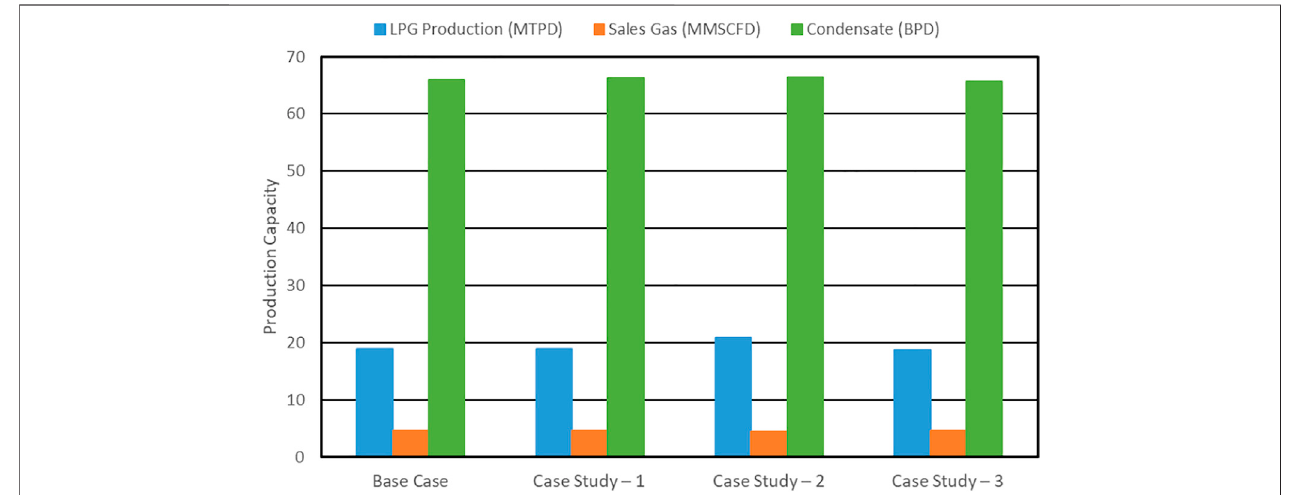
FIGURE 6 | Production capacity of LPG and other by-products for the base case and other case studies.